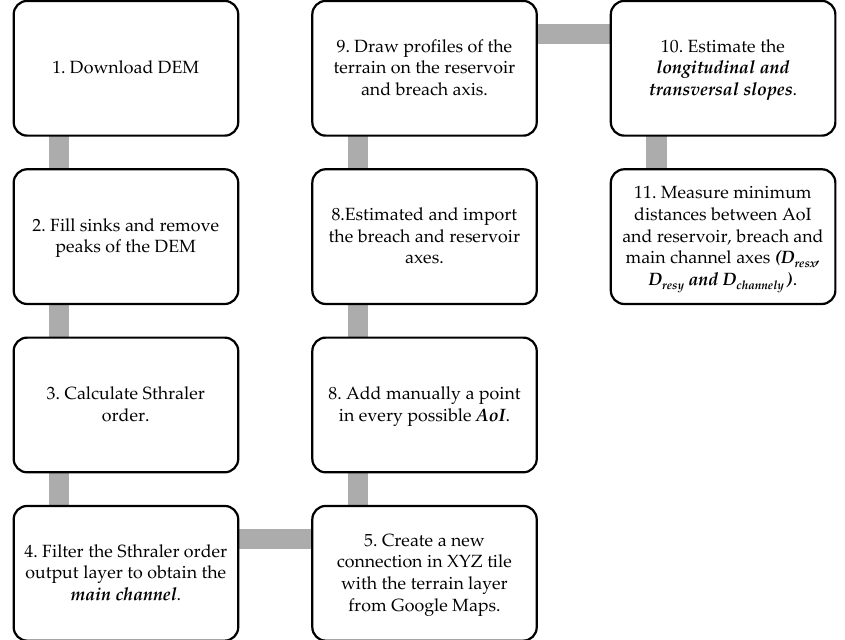
Figure 11. Flow chart processes in QGIS for parametrization of real terrain. The detailed description of each step is included in Supplementary Material Section